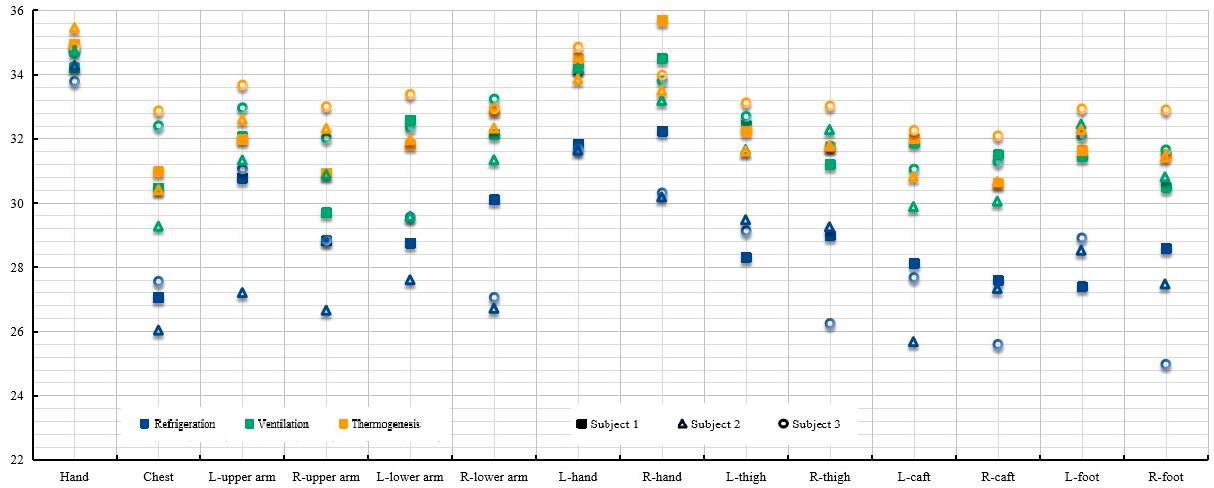
Figure 15. Temperature distribution of the three groups at each measuring point under three working conditions wearing the long clothing. The left vs. right temperature differences of subjects under different ventilated con- ditions are shown in Figure 16. The differences between the left and right sides of the upper arms, the lower arms, and the feet were obvious under the refrigerated conditions. The temperature of the left upper arm was more than 1.95 °C higher than that of the right, and the temperatures of the right lower arm and the right foot were 1.35 °C and 1.2 °C higher than the left of the same. The temperature differences between hands, thighs, and legs were less than 0.5 °C. Under ventilated conditions, the temperature on the left side of subject 1 was generally higher than the right side, and the temperature differences be- tween the left and right upper arms, thighs, and feet were large—about 2.36 °C, 1.22 °C, and 0.95 °C, respectively. Under heated conditions, the left upper arm and lower leg were 1.05 °C and 1.39 °C hotter than the right of the same. The right lower arm and hand were hotter than the left; the temperature differences were 1.05 °C and 1.2 °C, respectively.